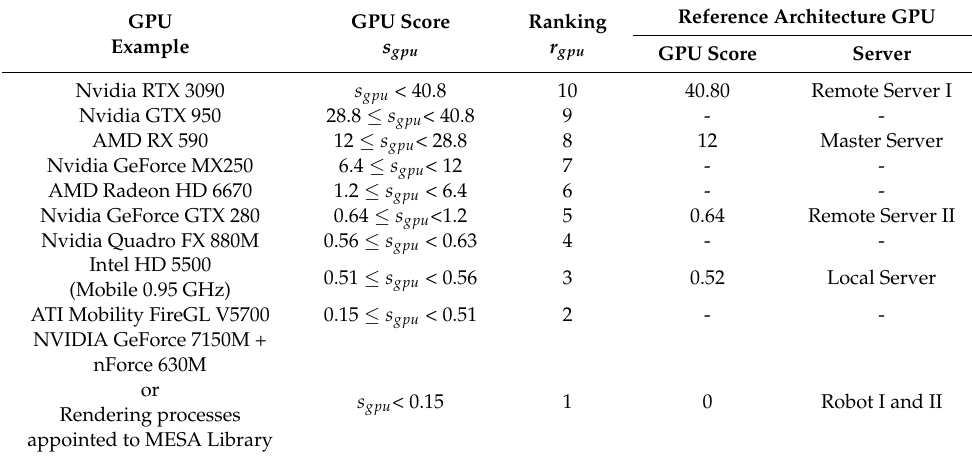
Table 3. Proposed Score for GPU.